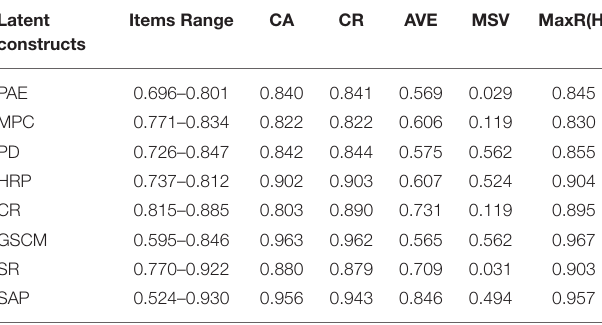
TABLE 2 | Properties of measurement